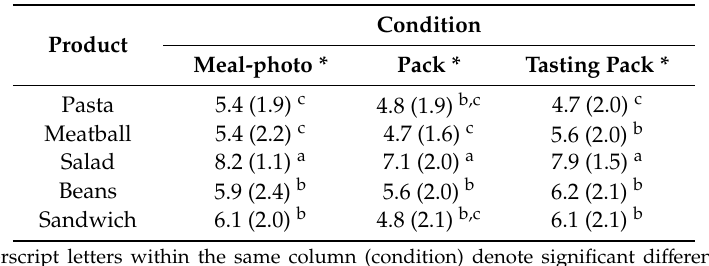
Table 5. Healthiness perception mean values, and the standard deviation in parentheses, of the five products evaluated on a plate (Meal-photo condition), in the pack (Pack alone condition) and after tasting with the packaging in view (Tasting-Pack alone